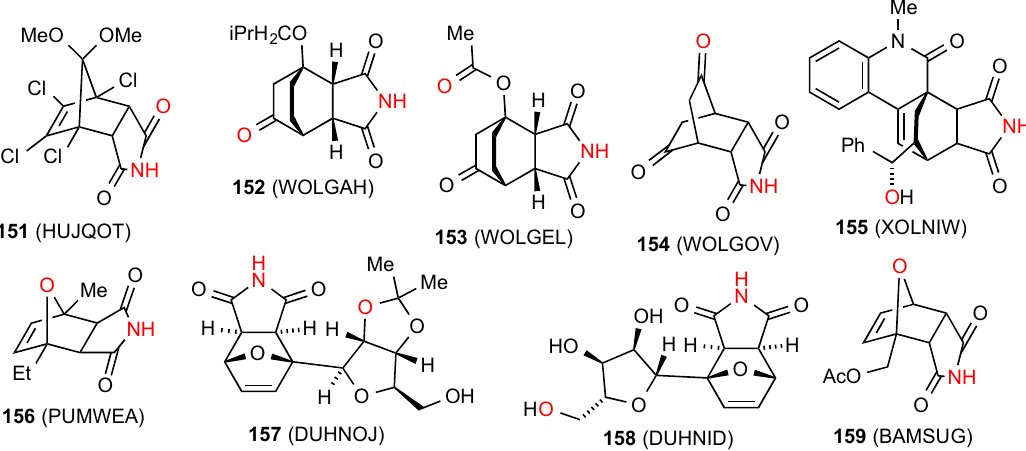
Figure 46. Bicyclo[2.2.1] and [2.2.2]-fused succinimides showing patterns G and F.